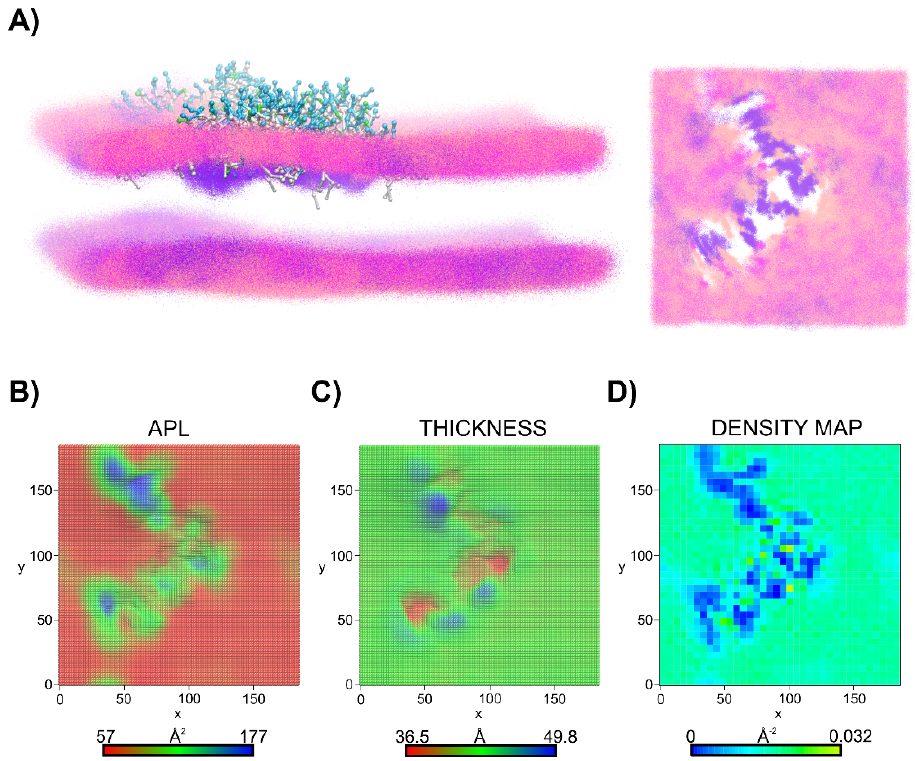
Figure 8. C 8 -LL-I induced membrane thinning in the DPPG/LysPG/CDL2 bilayer. ( A ) Superimposed snapshots from the last 500 ns of the DPPG/LysPG/CDL2 binding CG MD simulations for C 8 -LL-I. For clarity, only the phosphate beads along the trajectory part from 9.5 to 10 µs are shown, while the worm-like lipopeptide micelle was only taken from the final snapshot (left view). To better visualize the holes caused by C 8 -LL-I in the upper leaflet of the membrane, the lipopeptide molecules were removed (right view). The DPPG, LysPG and CDL2 phosphate groups are indicated in pink, magenta and violet, respectively. Oktanoyl tails and nonpolar amino acids are in white, positively charged residues are in cyan, while polar noncharged residues are in green. ( B ) Area per lipid (APL) map in the upper leaflet of the DPPG/LysPG/CDL2 membrane (top view), and ( C ) membrane thickness map (top view). ( D ) Two-dimensional density map of all the lipids in the upper leaflet of the DPPG/LysPG/CDL2 membrane (top view).